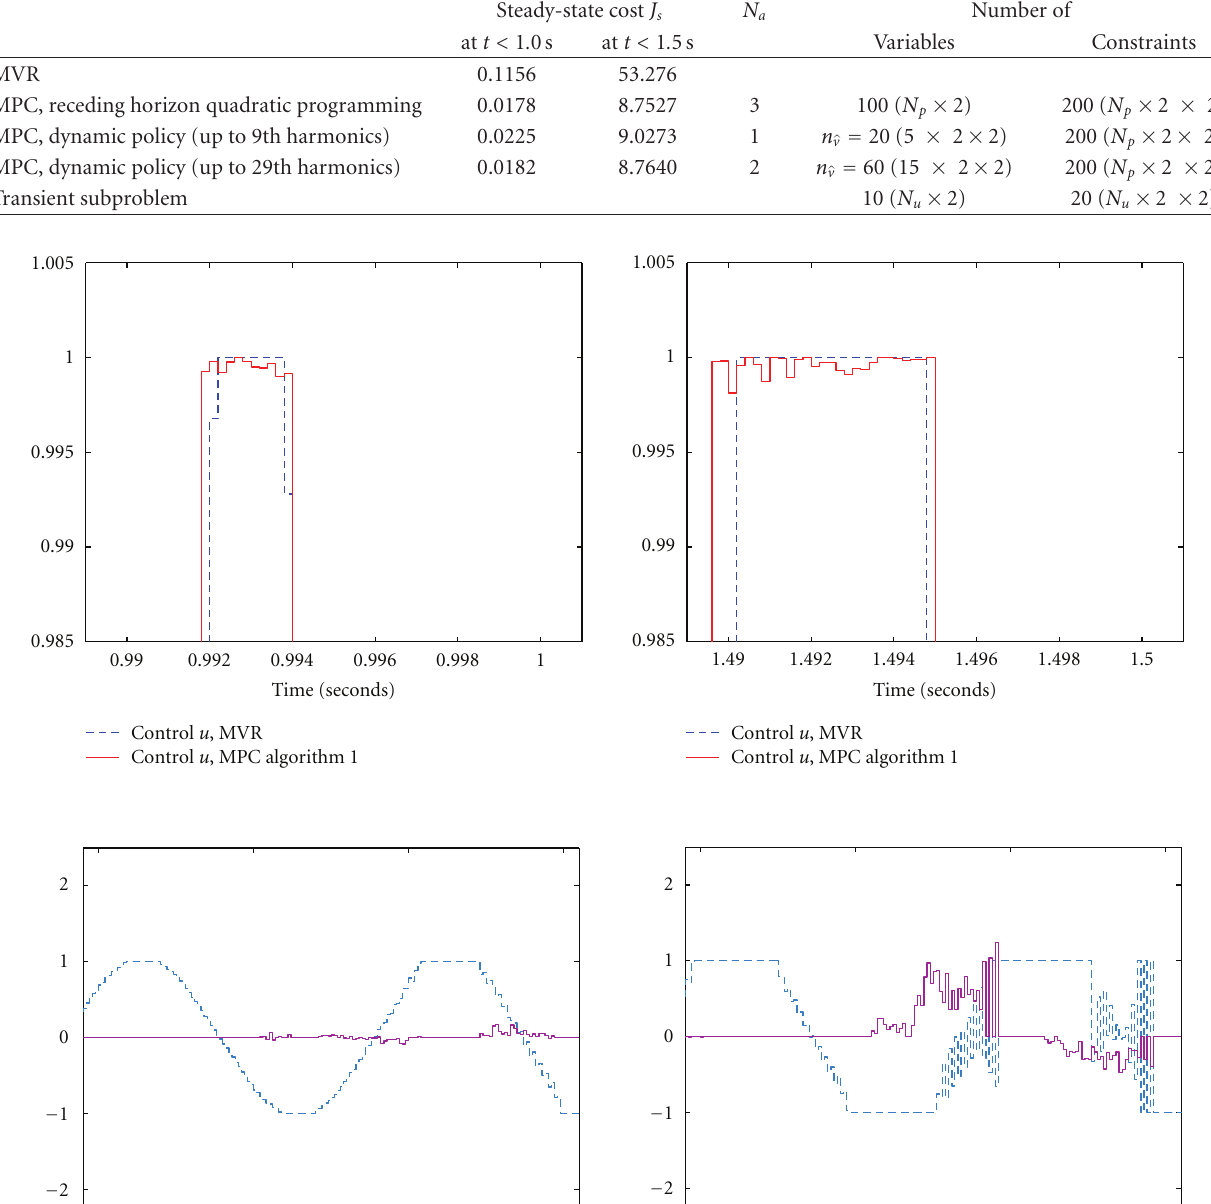
Table 3: Summary of J s values for various cases studied.